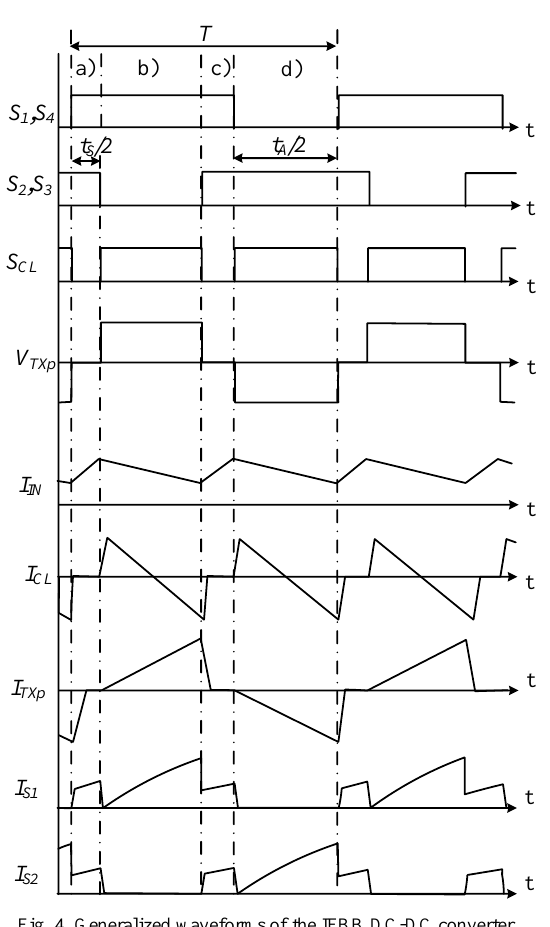
Fig. 4. Generalized waveforms of the IFBB DC-DC